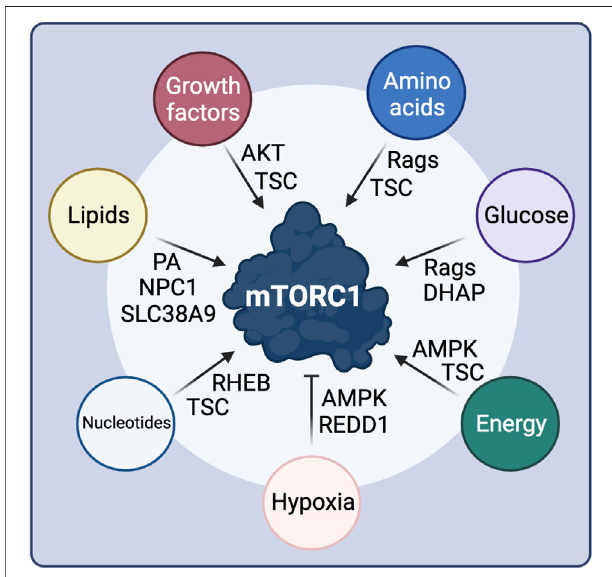
FIGURE 3 | Intra- and extra-cellular stimuli control mTORC1 activity through diverse signaling cascades and upstream mTORC1 regulatory proteins. See text for details. Created with